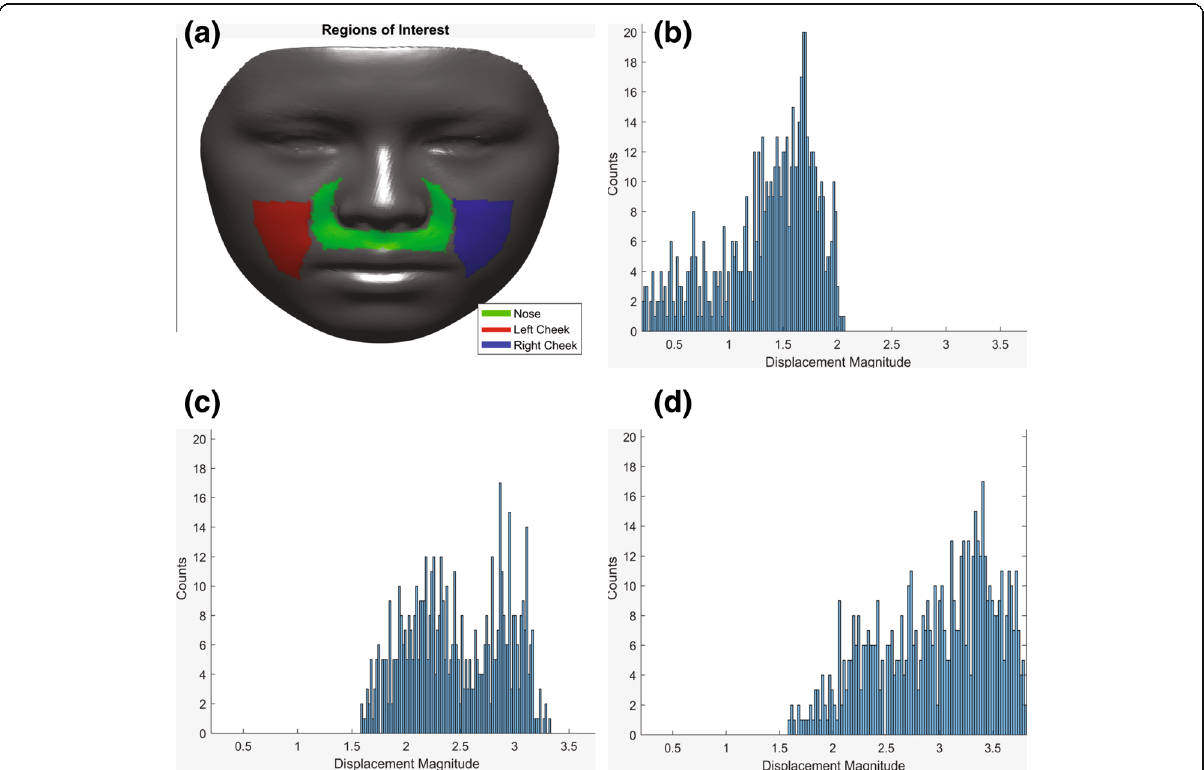
Fig. 12 Face divided in three main areas of nose, right and left cheek to quantify the vectors ( a ). Magnitude of the vectors representing changes in each area presented in histogram ( b – d ). X -axis represents the vectors ’ magnitude and Y -axis represents the number of vectors of each variable